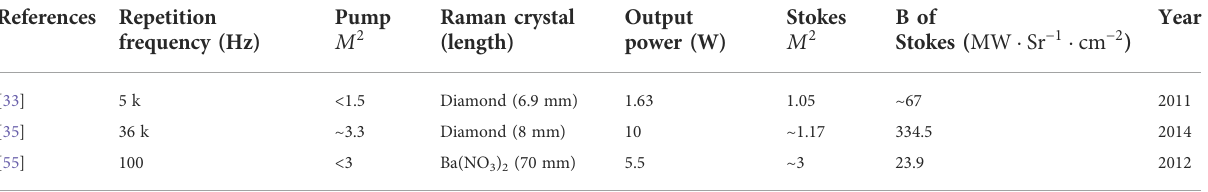
TABLE 5 The summary of brightness enhancement ns pulsed Raman lasers.